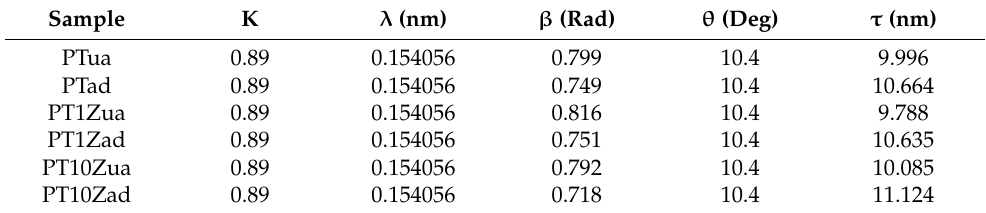
Table 2. β phase crystal size calculation results.